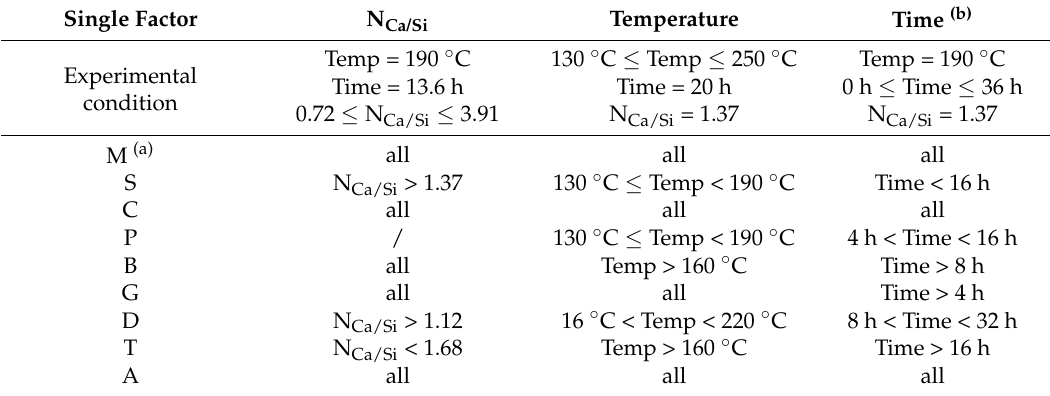
Table 1. An overview of mineral phases with various reaction